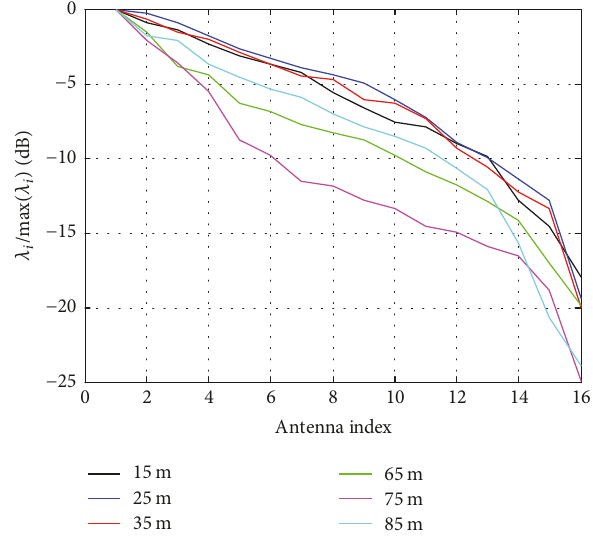
Figure 19: Normalized singular values at each value of link distance. Table 6: Ergodic capacity versus link